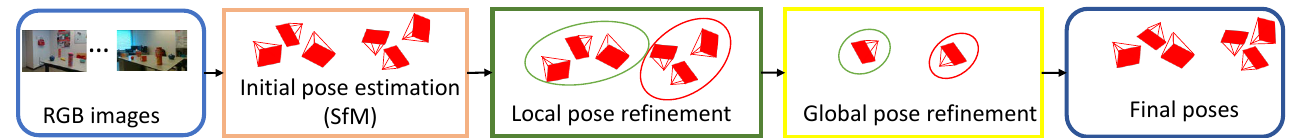
Figure 4. The pipeline of the pose estimation process. The input are RGB images and the initial poses of these images are estimated by Structure from Motion (SfM). After that, the initial poses are refined locally and globally.